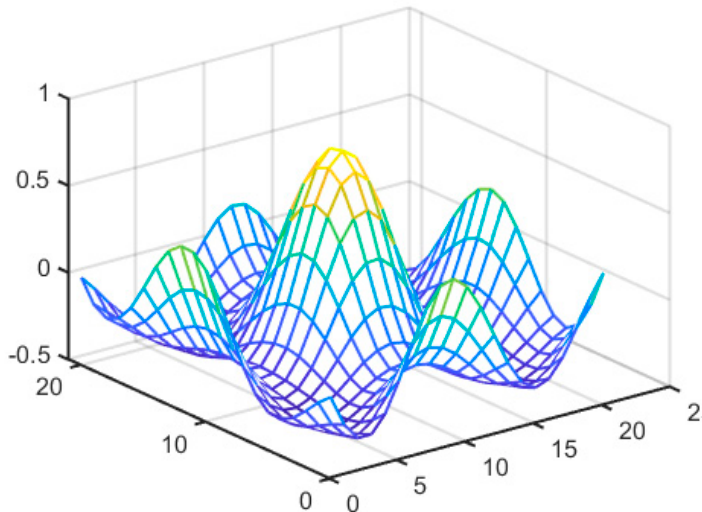
Figure 10. Correlation on one matching projected by a four-point initialization using a window of 31 × 31 pixels on a zone of 21 × 21 pixels.